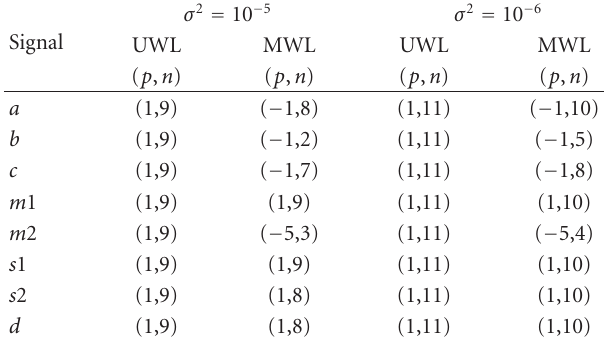
Table 2: UWL versus MWL wordlength